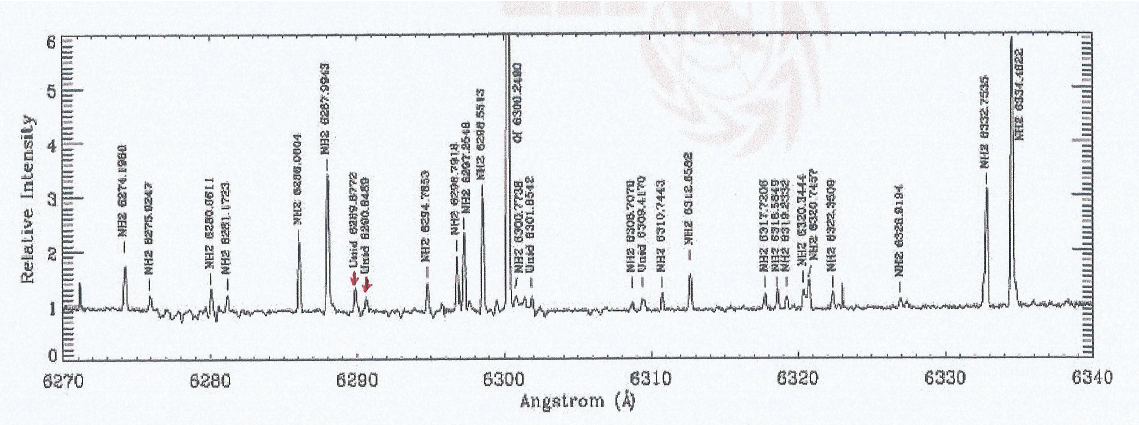
Figure 8. Fragment of the spectrum of comet Machholz (C/2004Q2). We found that 6289.88 Å and 6290.64 Å unidentified emissions (red ar- rows) are correlates in positions and profiles with fluorescence emissions of Cd-tetrabenzoporphyrine (Figure 6, red arrows) . The spectrum of comet Machholz was obtained by Sung-Won et al.